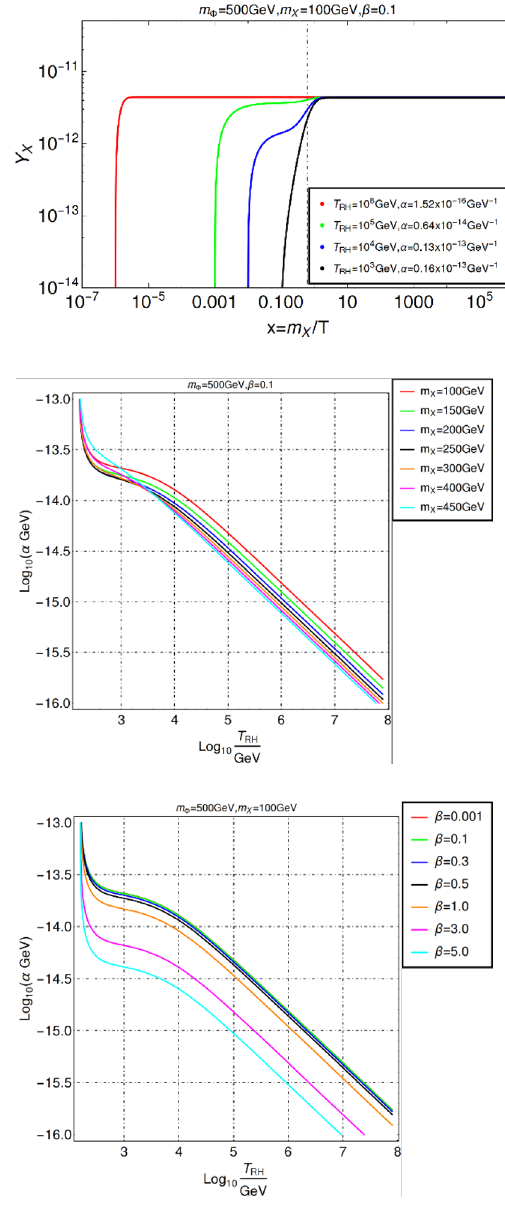
Figure 11 . Top panel: DM yield as a function of temperature for different choices of the reheat temperature T RH : { 10 5 , 10 2 , 10 , 1 } TeV shown in red, green, blue and black curves respectively. Here we have considered both annihilation and decay channels before EWSB where SM particles are massless while the dark particles are massive. In the post-EWSB scenario we have considered only the decays with massive states. The parameters chosen correspond to right relic abundance. In each of these plots the vertical dashed-dotted lines denote EWSB ( x EW ). Middle left: relic density allowed parameter space in terms of α − T RH where different colored contours correspond to different m X for a fixed m Φ = 100 GeV . Middle right: same as middle left panel, but for a different fixed m Φ = 500 GeV . Bottom left: same as middle panel but for different choices of β : { 0 . 001 , 0 . 1 , 0 . 3 , 0 . 5 , 1 . 0 , 3 . 0 , 5 . 0 } for m Φ = 100 GeV and m X = 10 GeV. Bottom right: same as bottom left with m Φ = 500 GeV and m X = 100